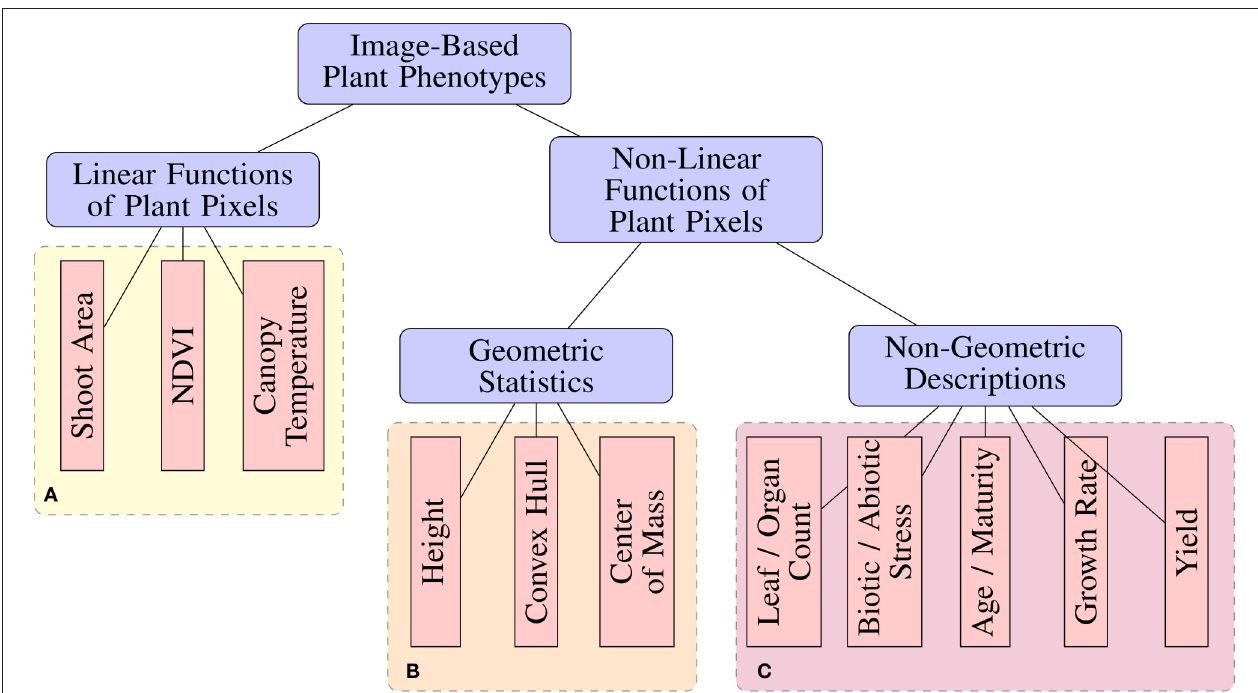
FIGURE 1 | A taxonomy of image-based plant phenotyping tasks. Phenotypes in (A,B) can be accurately measured using classical image processing techniques (Fahlgren et al., 2015b), while those in (C) are complex phenotyping tasks requiring more sophisticated analyses.